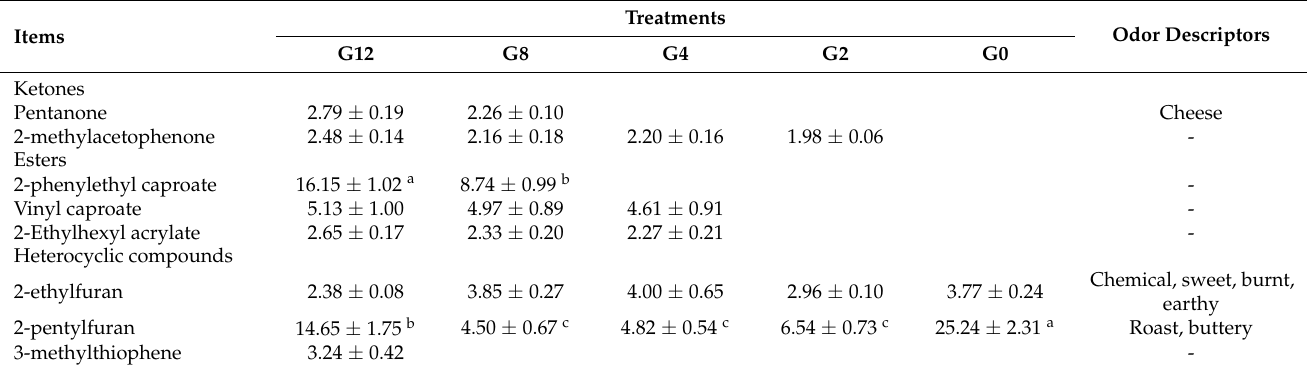
Table 8. Influence of restricted grazing time and indoor supplementary feeding systems on ketones, esters, and heterocyclic compounds of LT muscle in Tan lamb